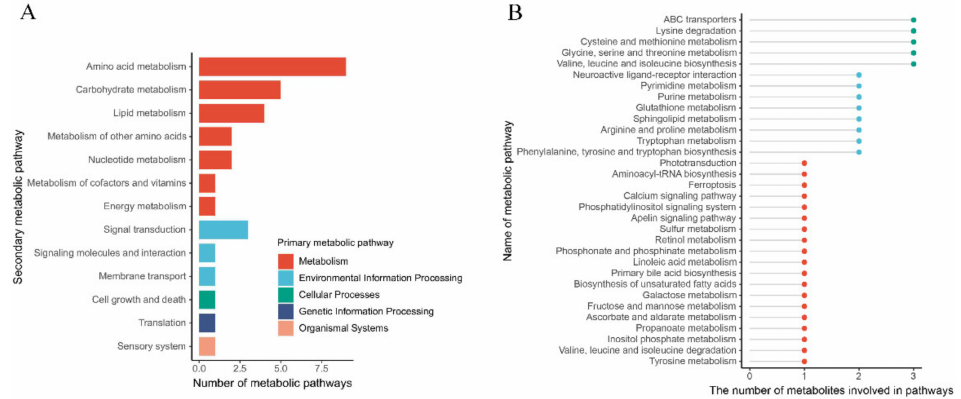
Figure 6. KEGG metabolic pathway enrichment was based on the differential metabolites between cage-reared ducks and floor-reared ducks in the uropygial glands. ( A ). primary metabolic pathways and secondary metabolic pathways. ( B ). Pathway analysis of the differential metabolites between cage-reared ducks and floor-reared